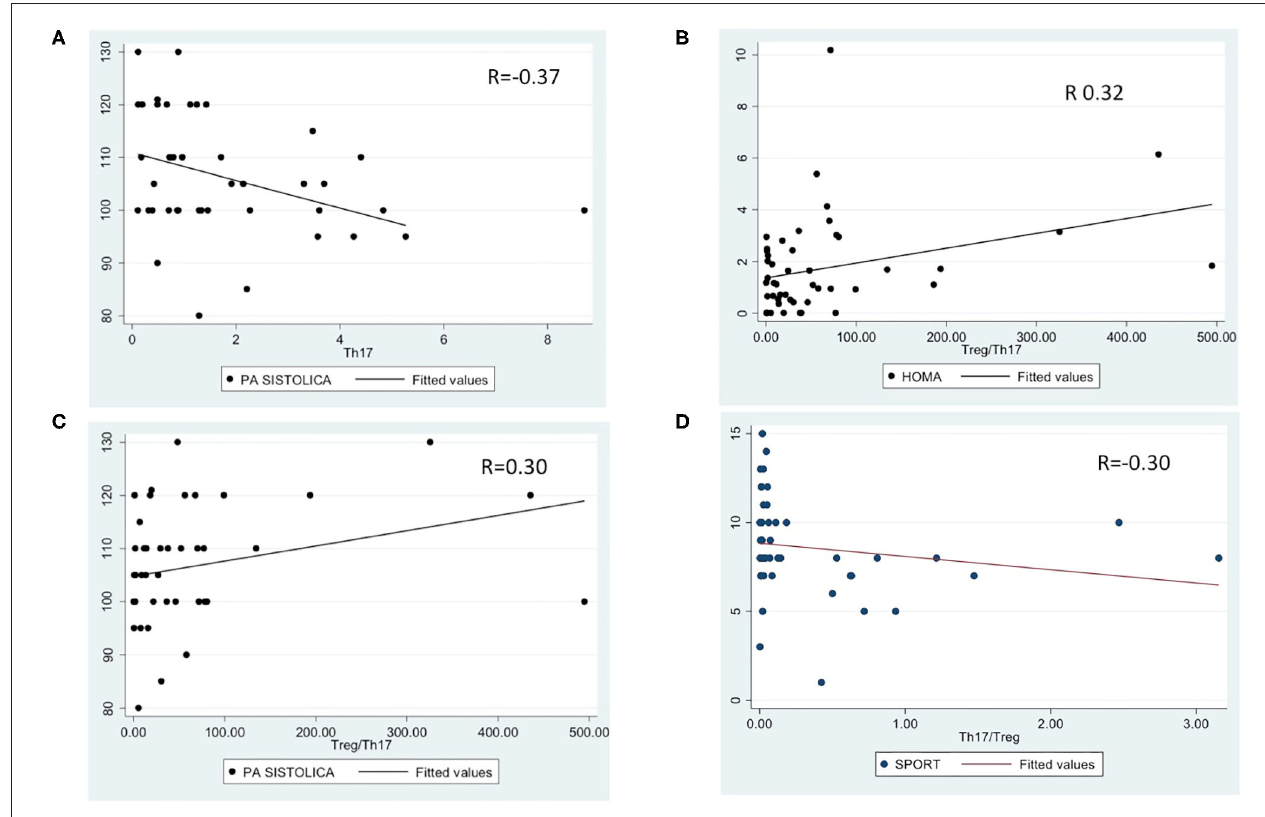
FIGURE 2 | Significant correlations between lymphocyte subpopulations and metabolic data. (A) : correlation between Th17 percentage and systolic hypertension ( p = 0.01, r = − 0.3769); (B) : correlation between Treg/Th17 ratio and HOMA-IR ( p = 0.02, r = 0.32); (C) : correlation between Treg/Th17 ratio and systolic hypertension ( p = 0.05, r = 0.30); (D) : correlation between Treg/Th17 ratio and physical activity ( p = 0.04, r = −